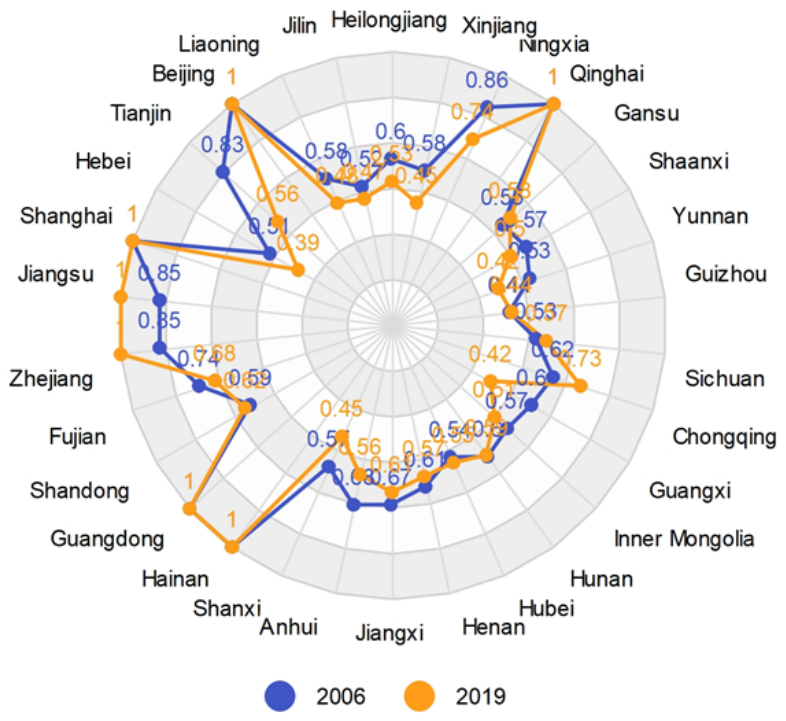
Figure 3. China’s carbon emission efficiency values by provinces in 2006 and 2019.